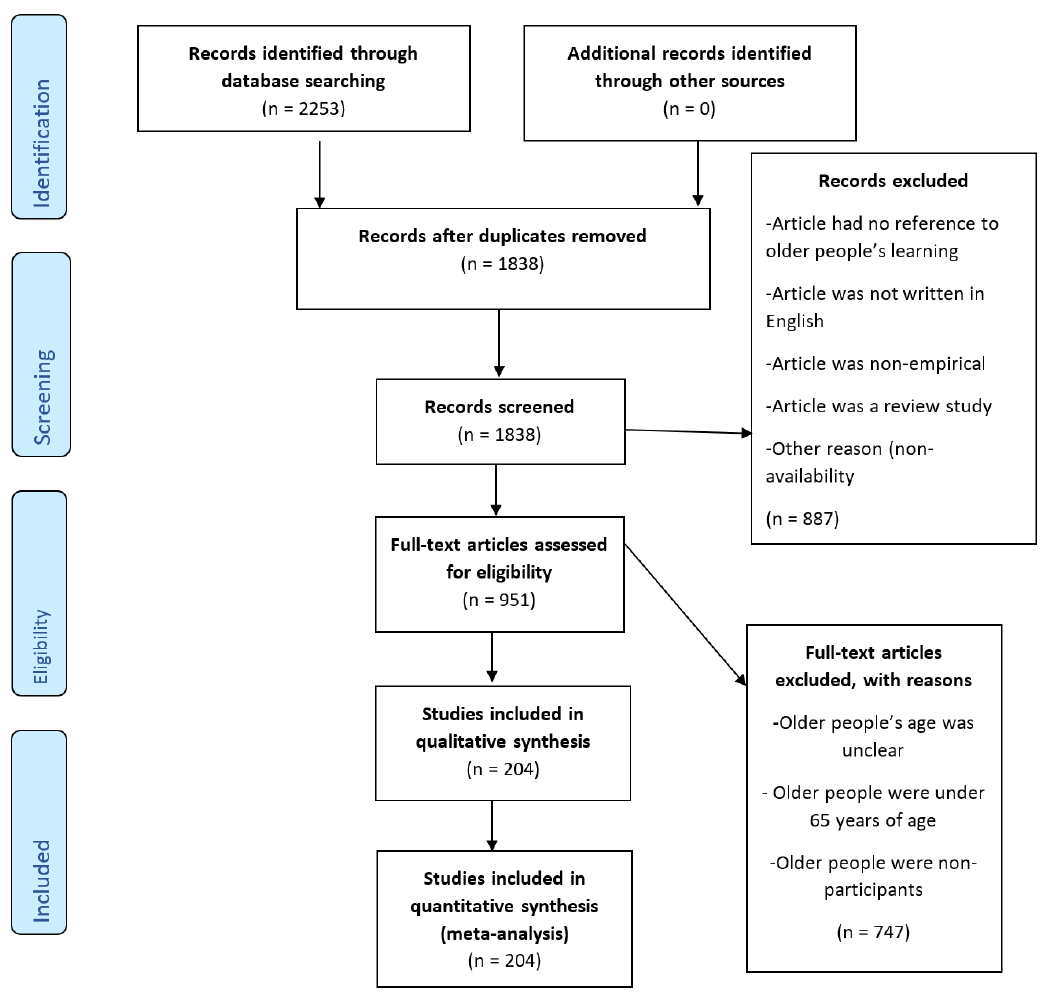
Figure 1 . The Scoping review process studying participation of older people in learning studies (authors’ own